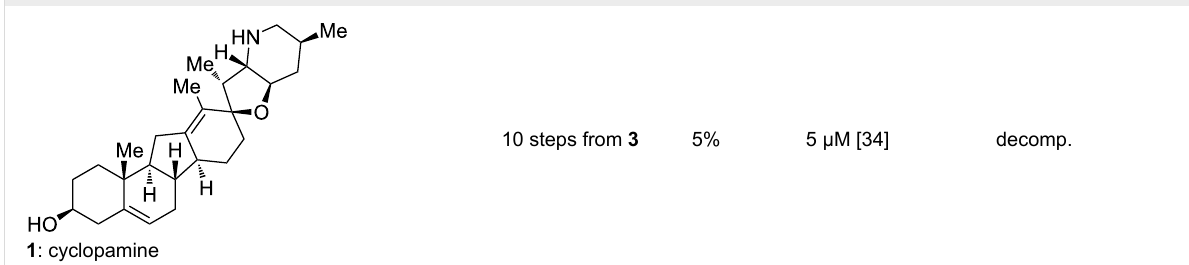
Table 1: Synthesized exo -cyclopamine derivatives, number of steps, yields, results of their biological testing, and stability towards acid. (continued)